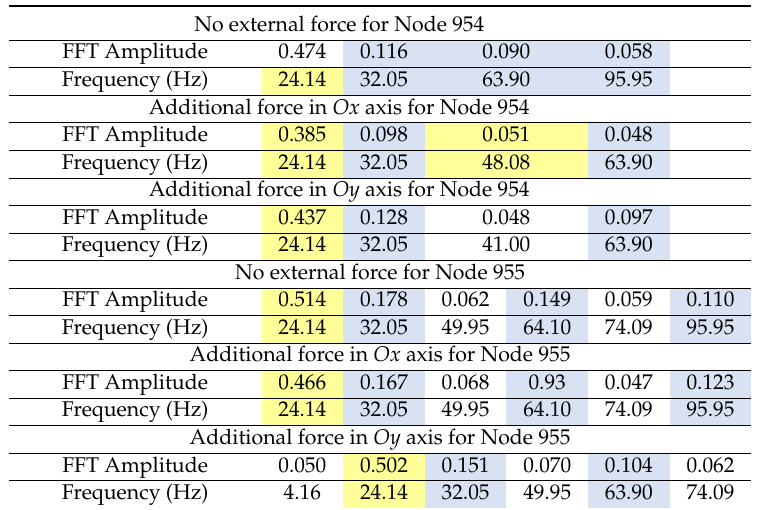
Table 1. List of parameters read from the characteristics shown in Figures 8 and 9.